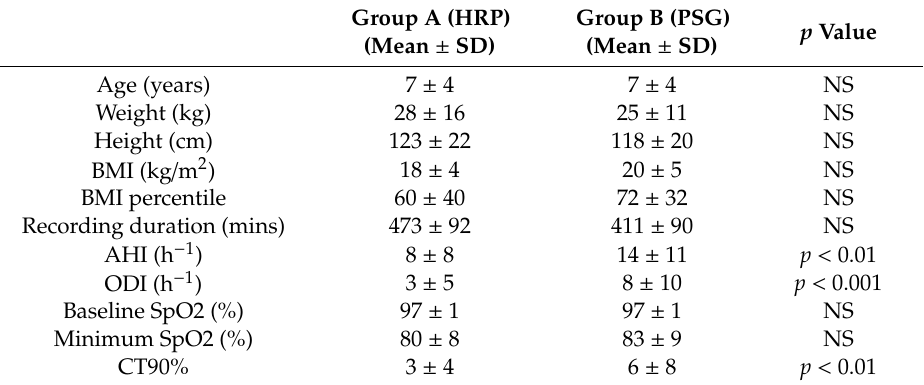
Table 5. Anthropometric characteristics and respiratory variables by group.